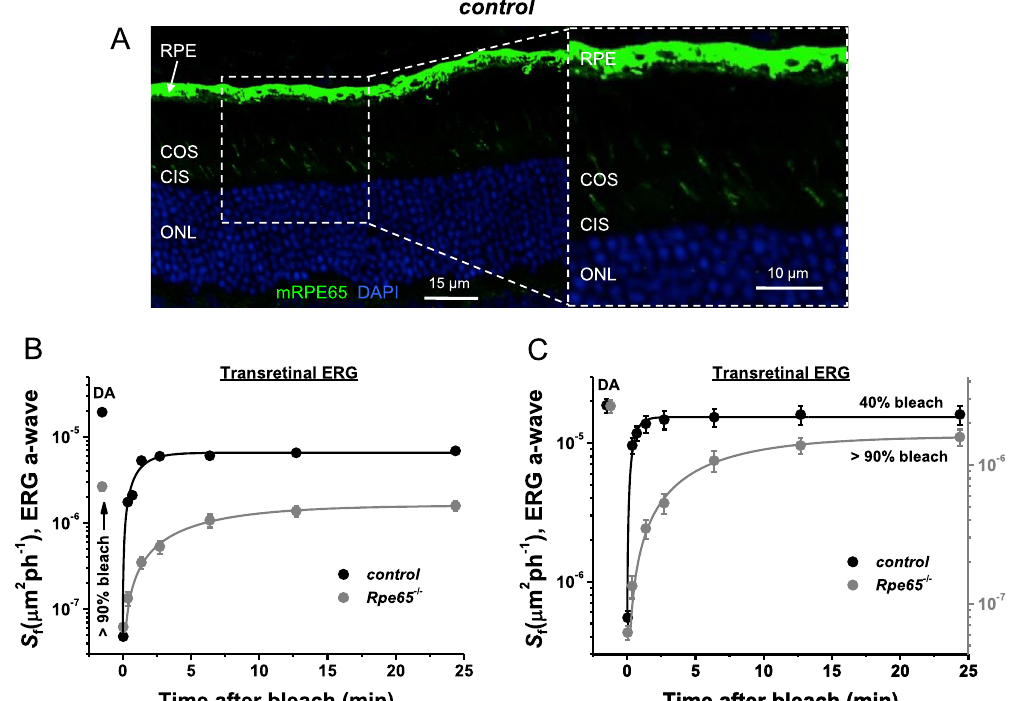
Figure 4. Delayed M-cone dark adaptation in retinas of RPE65-deficient mice. ( A ) Endogenous expression of RPE65 protein in cones of control Rpe65 + / + Gnat1 − / − mice was confirmed by immunohistochemistry using PETLET RPE65 antibody (green). Cell nuclei were stained with DAPI (blue). RPE: retinal pigmented epithelium; COS: cone outer segments; CIS: cone inner segments; ONL: outer nuclear layer. Scale bar, 15 μ m. The inset shows higher magnification of the selected area. Scale bar, 10 μ m. ( B ) Recovery of cone ERG a -wave flash sensitivity ( S f ; mean ± SEM) in isolated retinas of control (n = 9) and Rpe65 − / − Gnat1 − / − mice injected with Matrigel loaded with 9- cis -retinal (n = 12) after bleaching > 90% of cone pigment at time 0 with 505 nm LED light. Error bars for some points are smaller than the symbol size. Data were fitted with single-exponential functions that yielded time constants of ~1.2 min and 6.1 min, respectively. S fDA denotes the sensitivity of dark-adapted cones. ( C ) Comparison of the recovery of cone ERG a -wave flash sensitivity ( S f ; mean ± SEM) in isolated retinas of control Rpe65 + / + Gnat1 − / − mice (n = 9, left y-axis) and Rpe65 − / − Gnat1 − / − littermates injected with Matrigel loaded with 9- cis -retinal (n = 12, right y-axis) under conditions of bleaching causing equal initial cone desensitization (1.5 log units). Bleaching ~40% (control Rpe65 + / + Gnat1 − / − ) or > 90% ( Rpe65 − / − Gnat1 − / − ) of cone pigment at time 0 was performed with 505 nm LED. Data from Rpe65 − / − Gnat1 − / − mice were replotted from ( B ). Data were fitted with single-exponential functions that yielded time constants of ~0.5 min and 6.1 min, respectively. The y-axis for the data from mutant mice (right) was arbitrary scaled up to match the initial dark-adapted cone sensitivity ( S fDA ) of the two